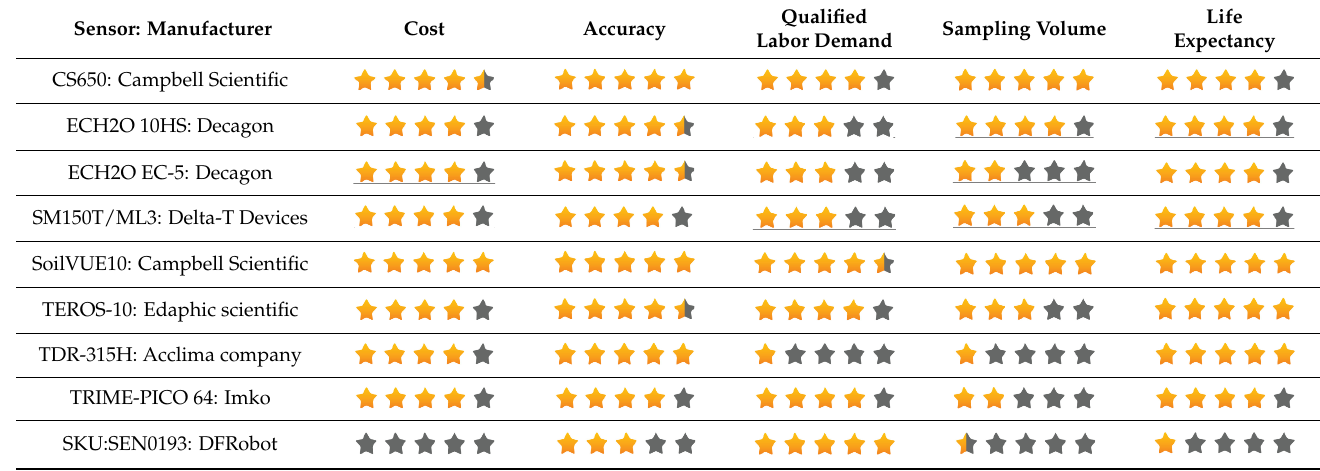
Table 5. Qualitative comparison of different soil moisture sensors.